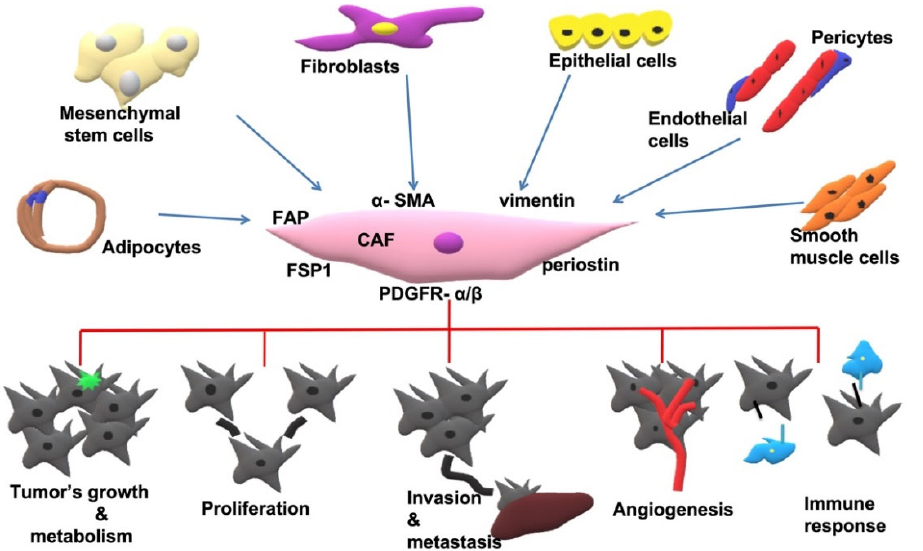
Figure 1. Origin of CAFs and their relation to cancer. CAFs might be derived from mesenchymal cells, fibroblasts, epithelial cells, endothelial cells, adipocytes, pericytes and smooth muscle cells. The main markers that can be recognized regarding GI cancers are: FAP, α -SMA, vimentin, FSP1, PDFGR- α / β and periostin. They are related to cancer by promoting tumor growth, cancer cell proliferation, invasion and metastasis, angiogenesis and immune remodeling.